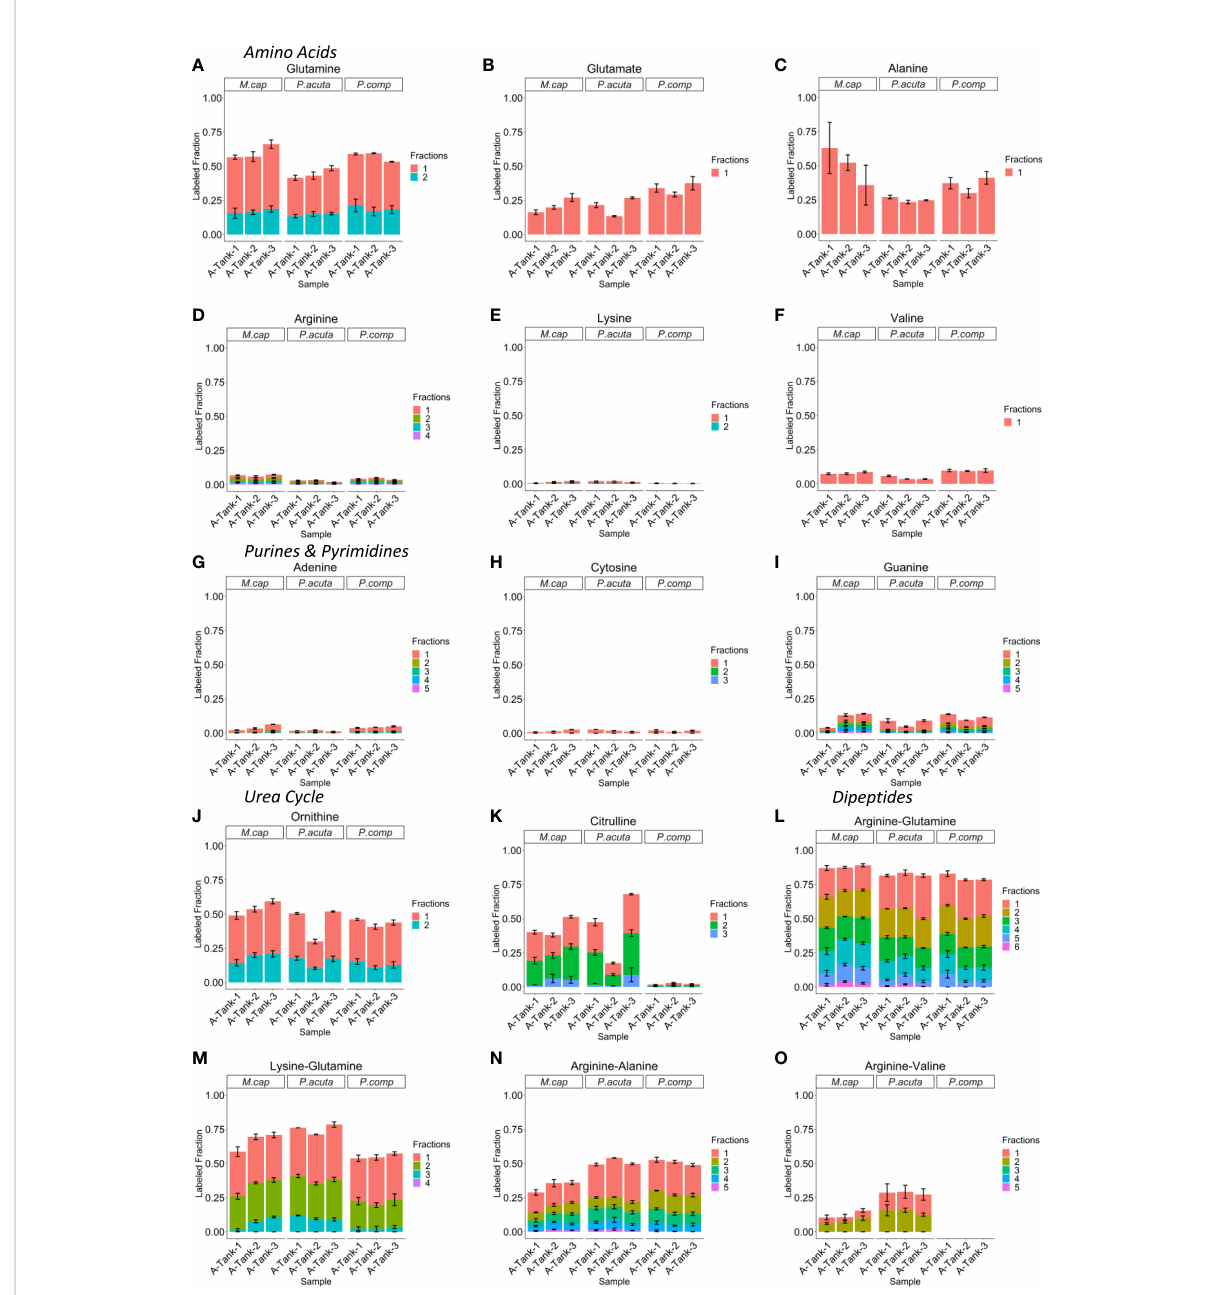
FIGURE 3 15 N-NH 4+ incorporation in several metabolite classes. (A – F) Labeled fraction stacked bar plots for several amino acid class metabolites. (G – I) Labeled fraction stacked bar plots for several purine and pyrimidine class metabolites. (J, K) Labeled fraction stacked bar plots for several urea cycle class metabolites. (L – O) Labeled fraction stacked bar plots for several dipeptide class metabolites. Plots depict the labeling pattern of three ambient temperature biological replicate tanks for M. capitata , P. acuta , and P.compressa respectively. The fraction number indicates the number of 15 N being incorporated. Error bars re fl ect technical replicate of n=3 for each individual tank